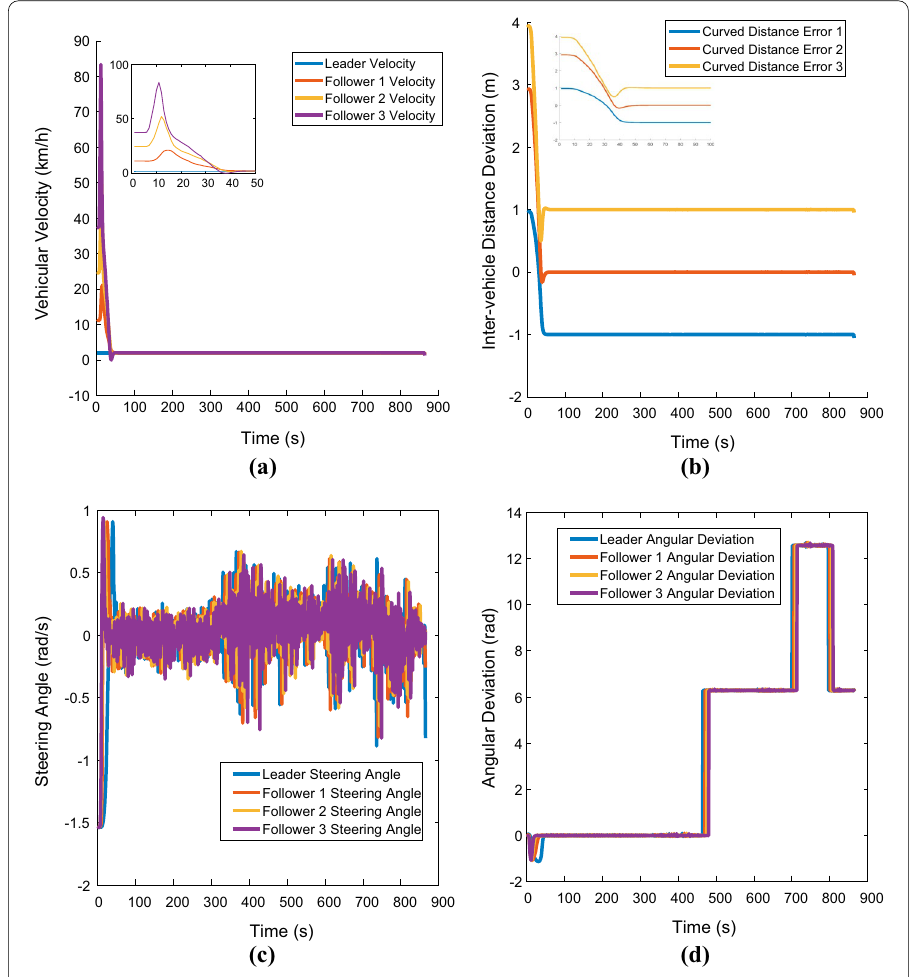
Fig. 7 Centralized control by leader: a vehicular velocity; b vehicular distance error; c steering angle; d angular